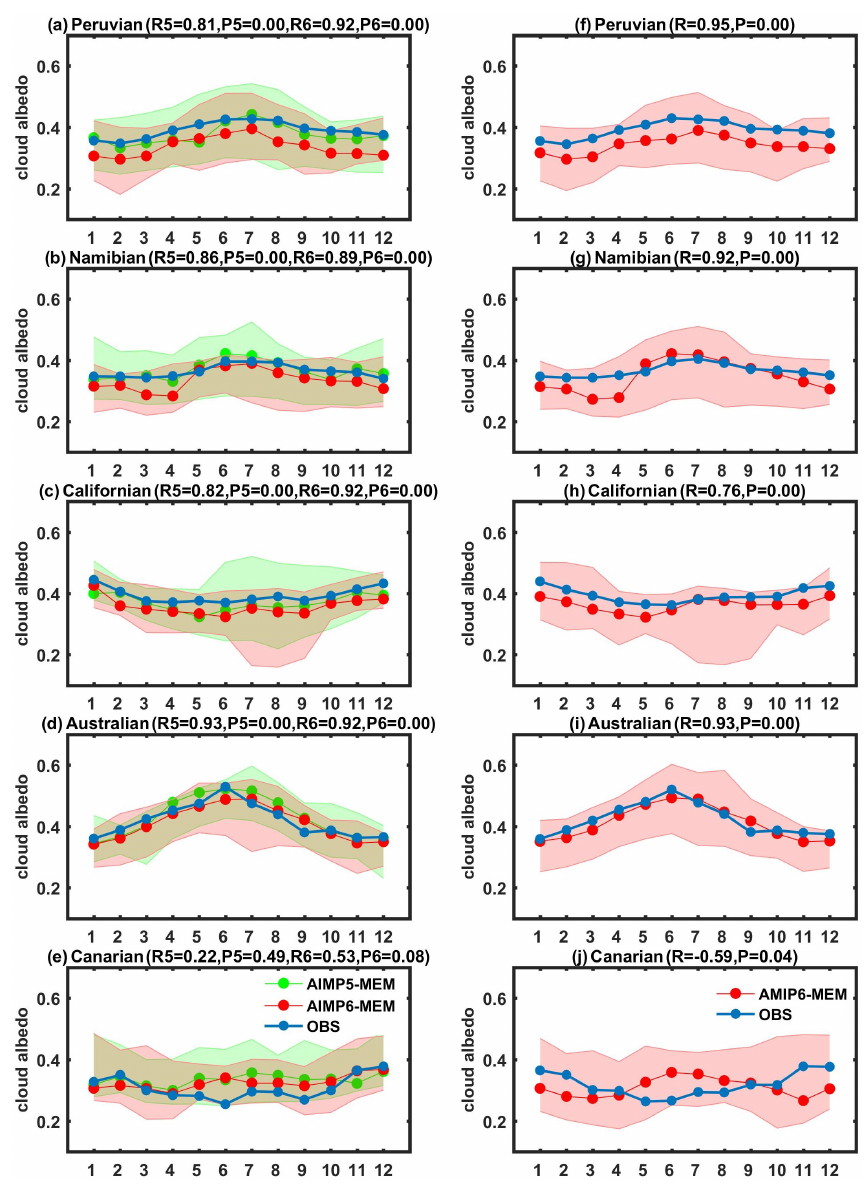
Figure 5. Annual cycles of the cloud albedo estimated by (a–e) AMIP5 and AMIP6 multimodel ensemble mean during 2003–2008 and (f–j) AMIP6 multimodel ensemble mean during 2003–2014 compared with satellite observations over the (a, f) Peruvian, (b, g) Namibian, (c, h) Californian, (d, i) Australian and (e, j) Canarian regions. The green and red shaded areas indicate the range of the cloud albedo simulated by AMIP5 and AMIP6 models, respectively. The temporal correlations (R5 / R6 /R value) and P5 / P6 /P value (if P5 / P6 /P < 0.10, indicating the correlation R5 / R6 /R is significant) for the seasonal cycles of the cloud albedo obtained from satellite-based observations and models are given in